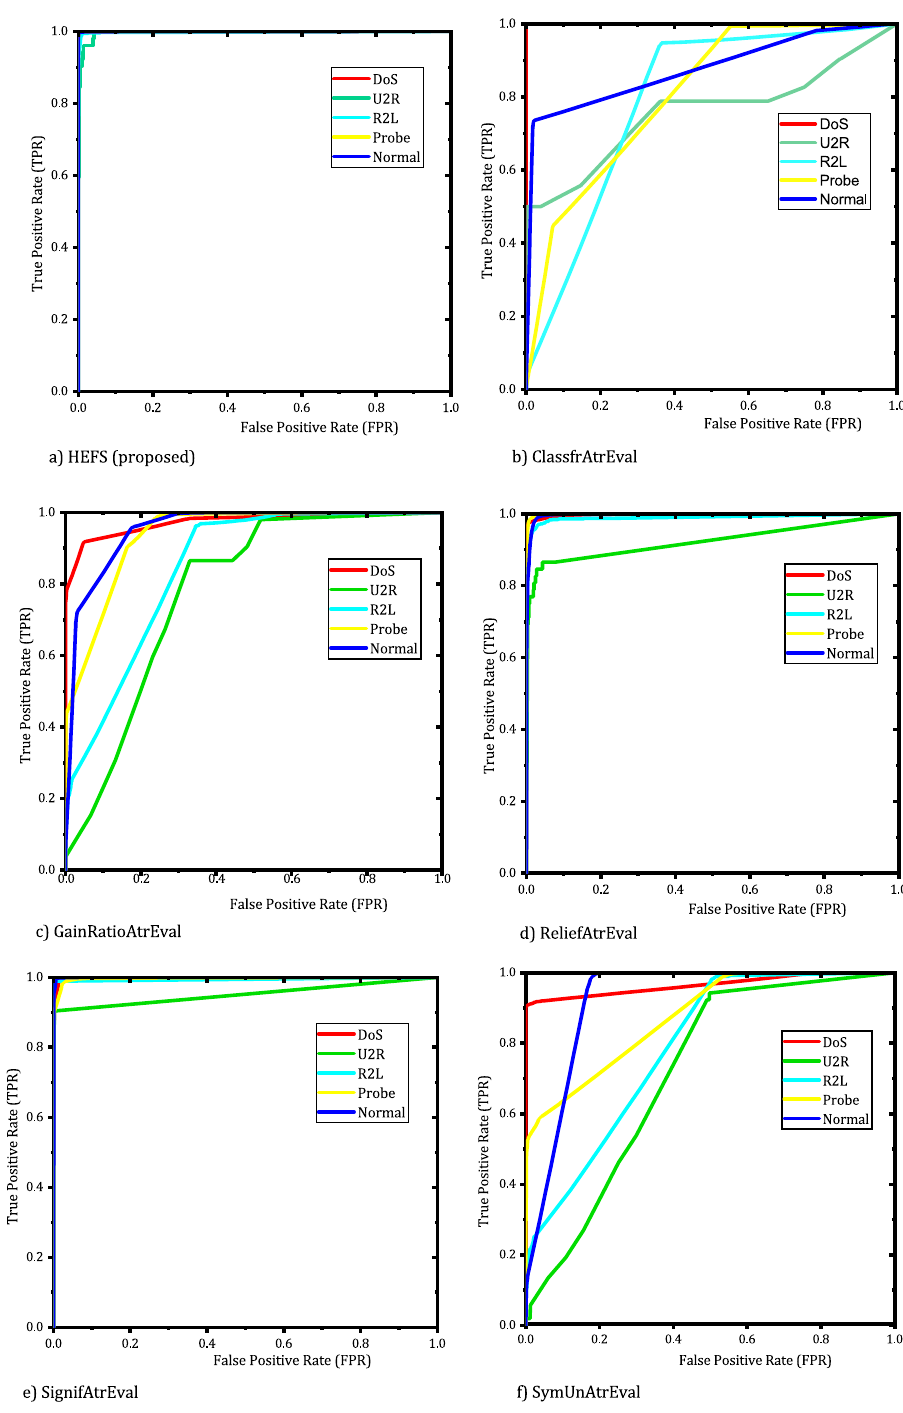
Fig. 6 The ROC curves of random forest classifier with the HEFS method and the five base feature selection methods, including classes: DoS, U2R, R2L, probe, and